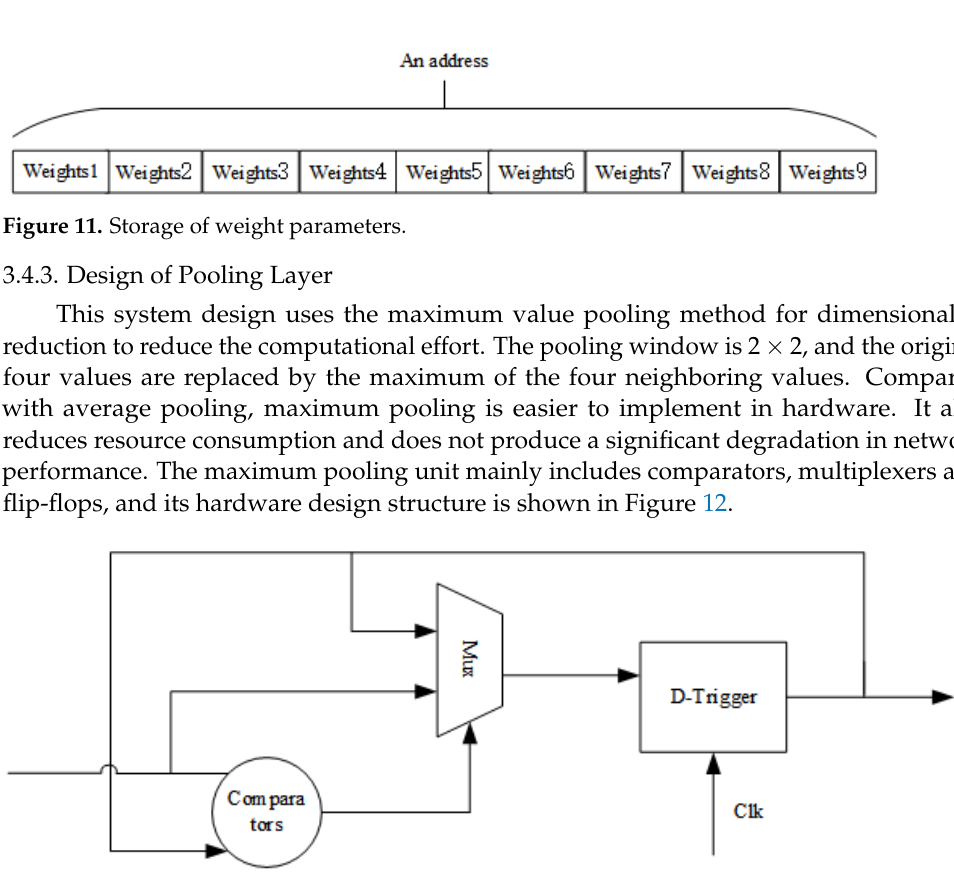
Figure 12. Hardware design architecture for maximum